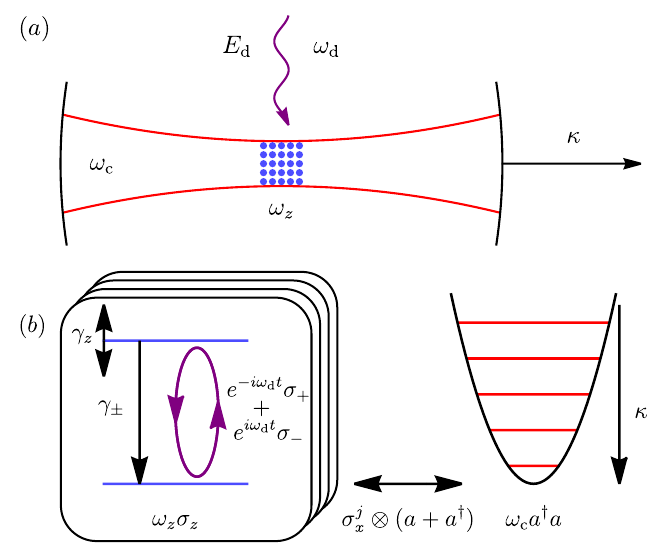
Figure 1: An illustration of the dissipative Rabi-Dicke model (a) and a depiction of its Hamiltonian as in Eq. 1 (b). A cavity (red) contains a set of identical two-level systems (blue) which experience circularly polarized Rabi-like driving (purple). γ ± and γ denote the coefficients of dissipative processes in the two-level systems, i.e. z spontaneous decay and dephasing. κ is the loss rate of the cavity, which determines the coherent output of the